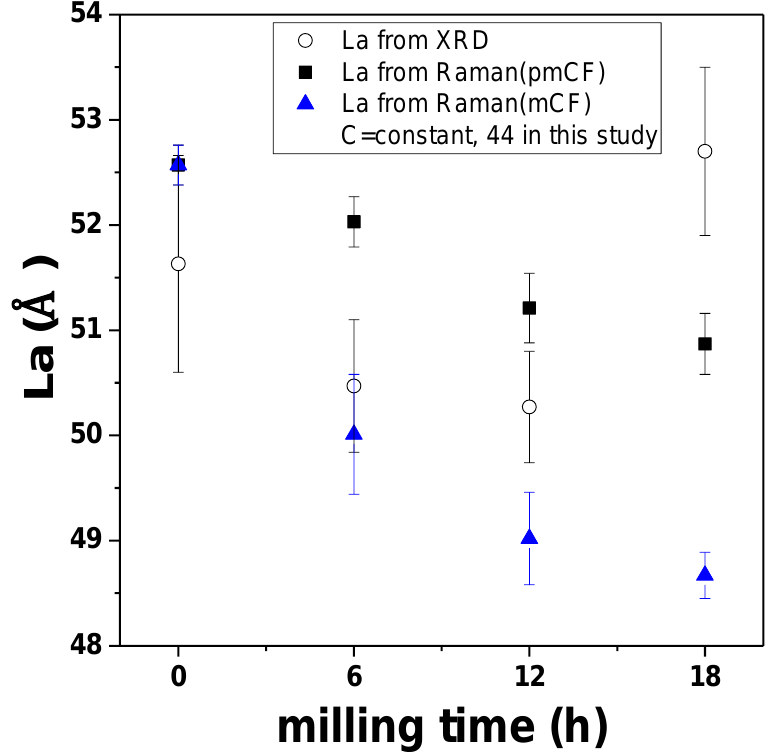
Figure 7. Correlation of L a values from Raman and XRD results.